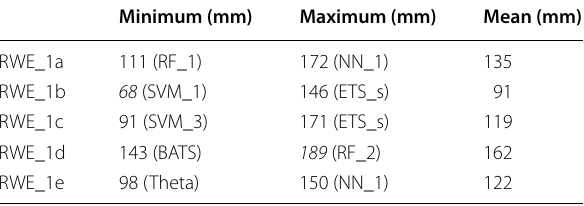
The minimum of the minimum values and the maximum of the maximum values are in italic